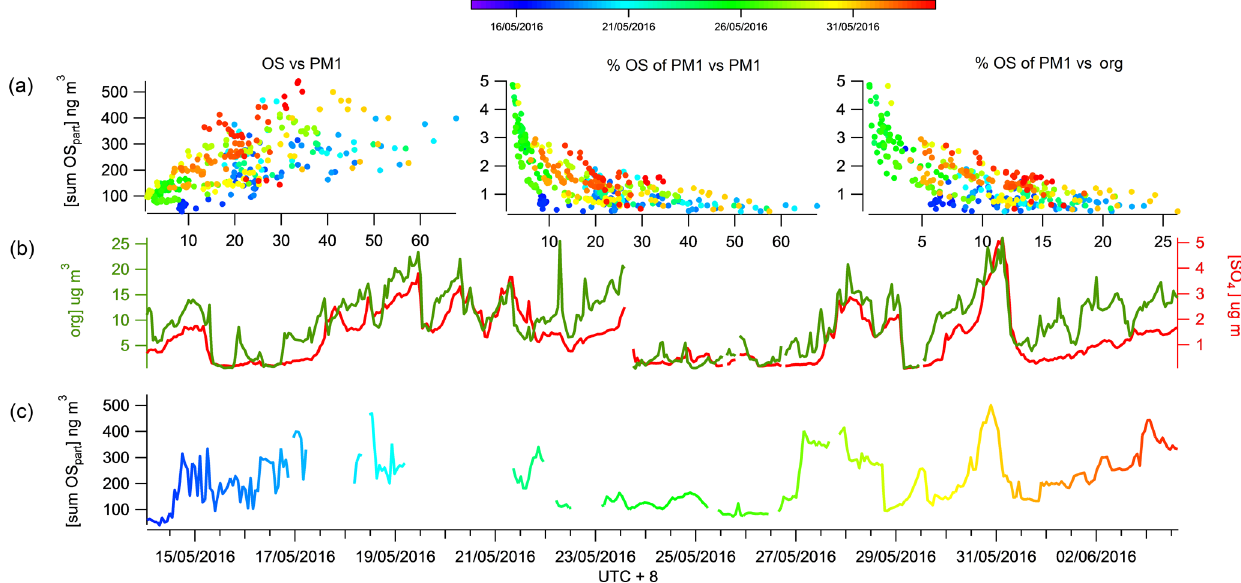
Figure 3. The time series of total SCO (colour coded by time) is displayed in panel (c) . The time series of the AMS organic (green) and sulfate (red) are displayed in panel (b) and the correlation of SCO to PM 1 , mass fraction of PM 1 and organics are displayed in panel (a) .